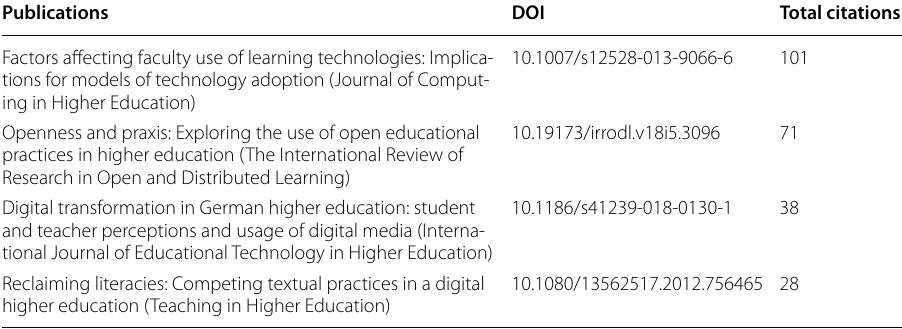
Table 1 Top publications by number of citations on educational competences and higher education